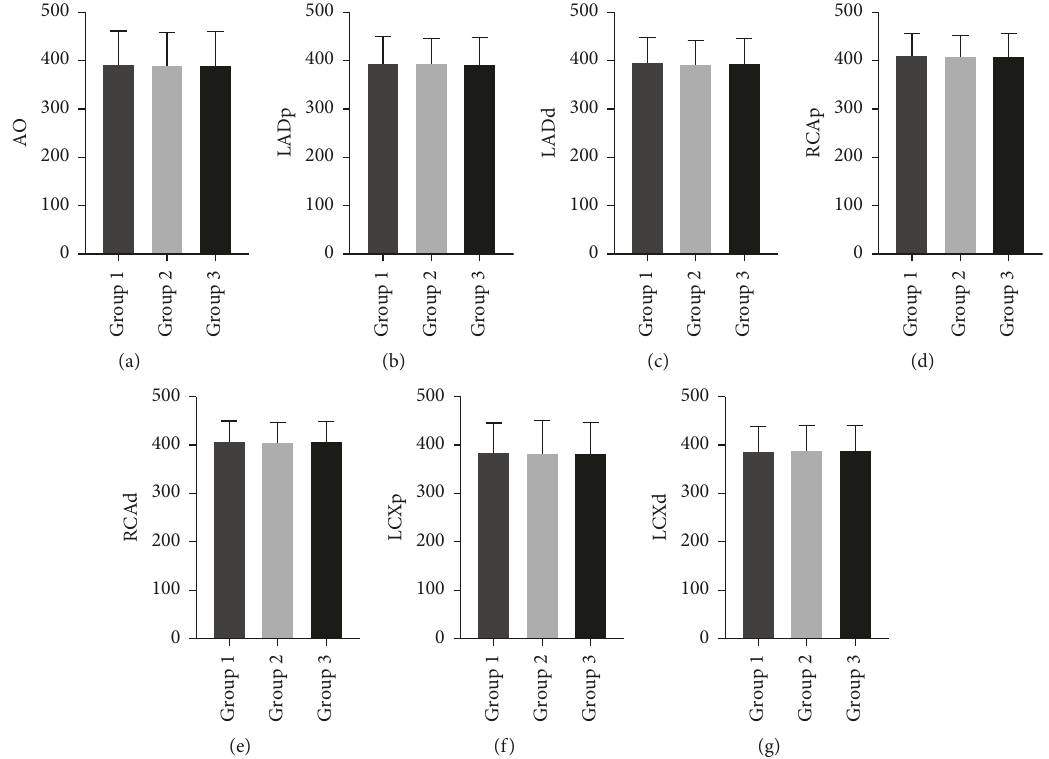
Figure 2: Comparison of objective indicators of image quality among the three groups of patients ( n � 100, x ± s , x ). (a ∼ g) Comparison between the three groups of AO (a), LADp (b), LADd (c), RCAp (d), RCAd (e), LCXp (f), and LCXd (g),